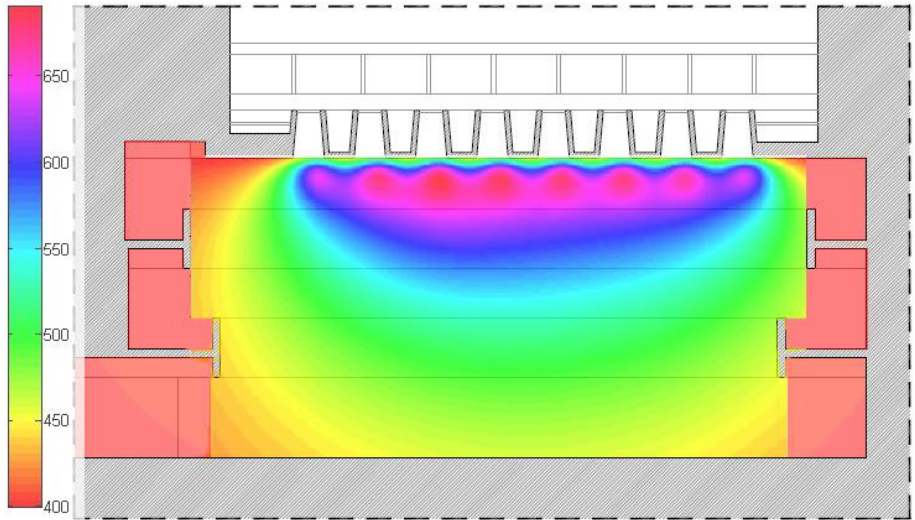
Figure 12. Rautatalo, Helsinki. Sectional values in summer.